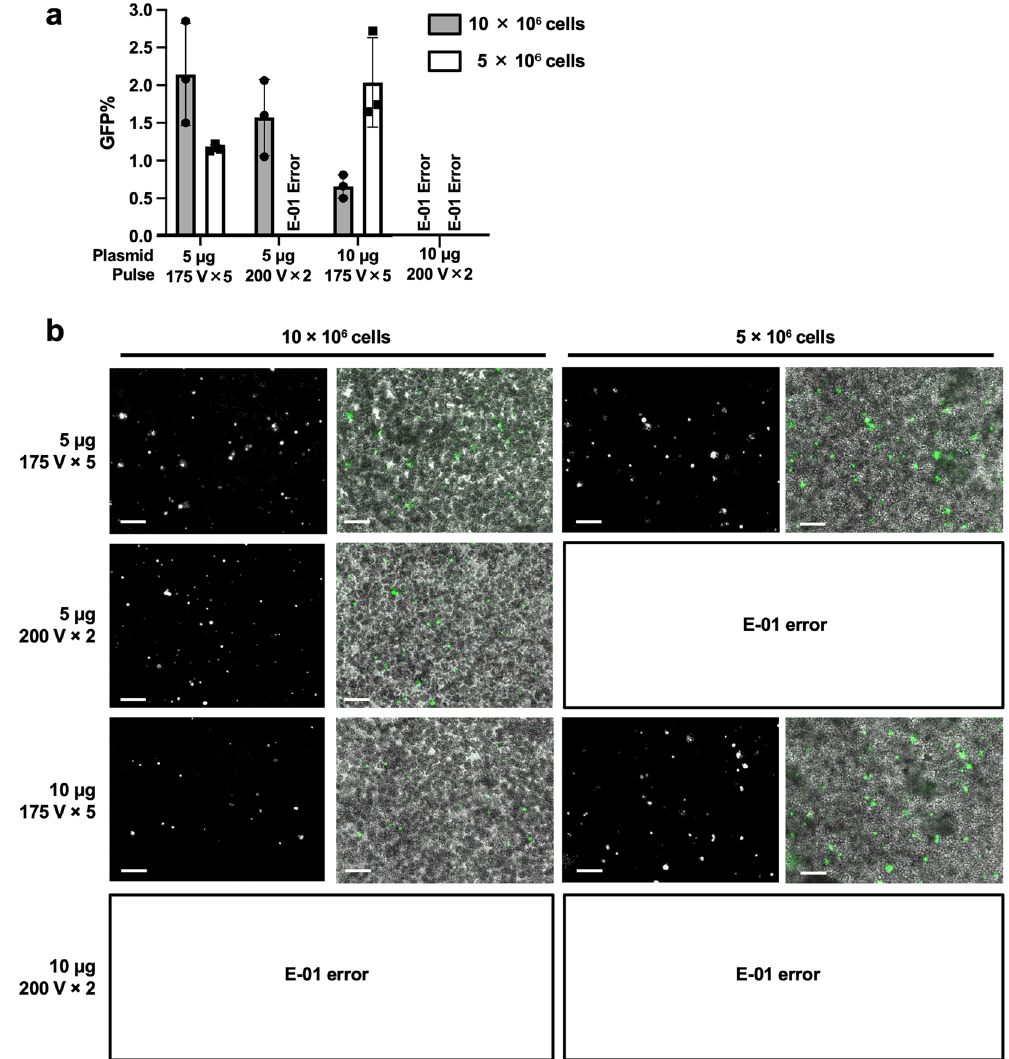
Figure 3. Comparison of GFP signals among the indicated pulse conditions and plasmid amount in the CRTW-3HE strain. ( a ) Percentage of GFP-positive cells after electroporation in each condition. The dots indicate individual data, the bars indicate mean values of the data, and the error bars indicate standard deviation. ( b ) GFP images (left side) and merge images (right side) are shown for each condition. The scale bars; 50 µm. E01-error in a and b ;